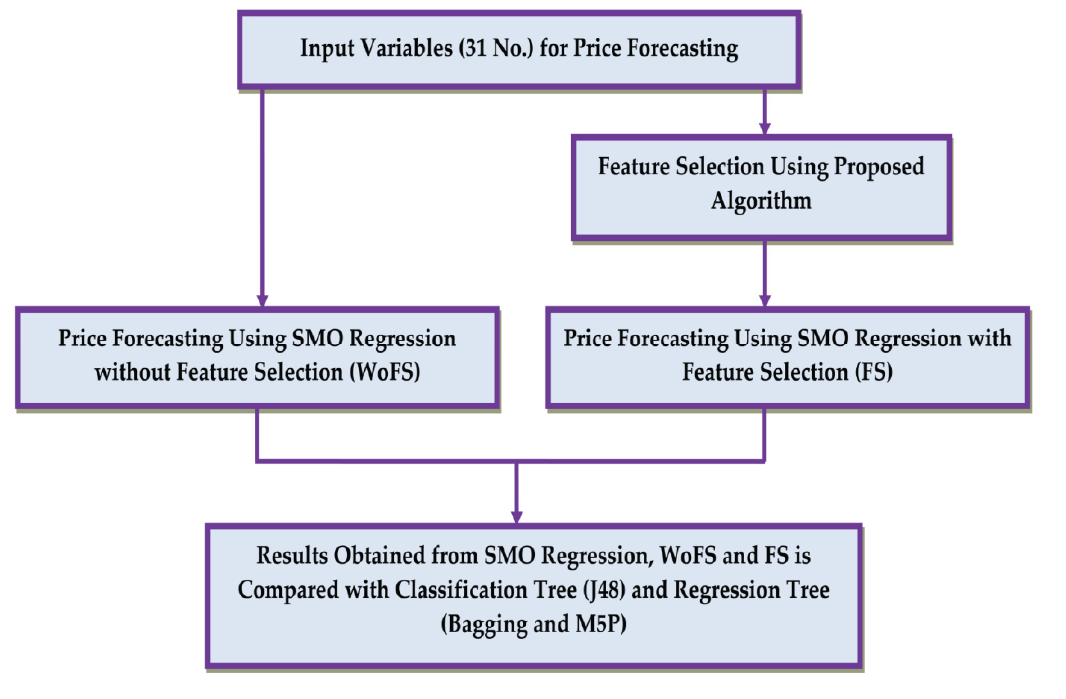
Figure 1. Proposed Figure 1. Proposed methodology.